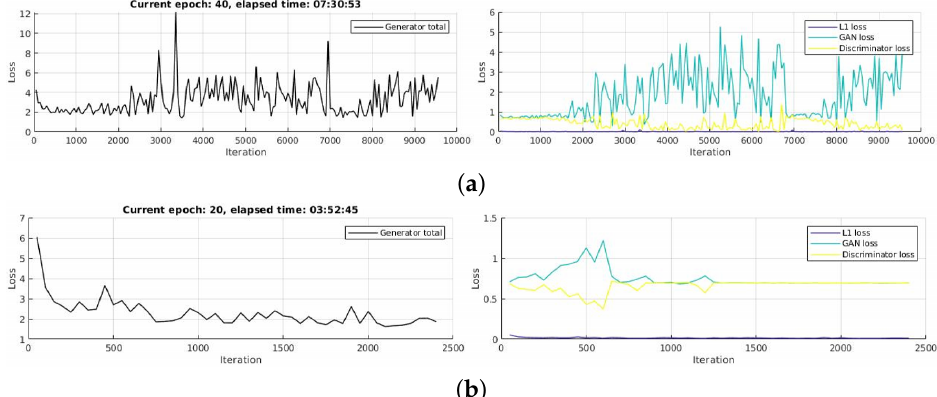
Figure 4. Comparison of loss convergence between different paramenters for CGAN-2 on Av- enue dataset. ( a ) shows the case where the losses are not convergent at 40 epochs, Minibatch size 64 and leakyReLU activation function, while ( b ) illustrates a good set of parameters, E = 20, M = 128, A = eLU , corresponding to good loss convergence. We find that the total loss is stable from 1000th iteration, and each loss is almost convergence. Best viewed in